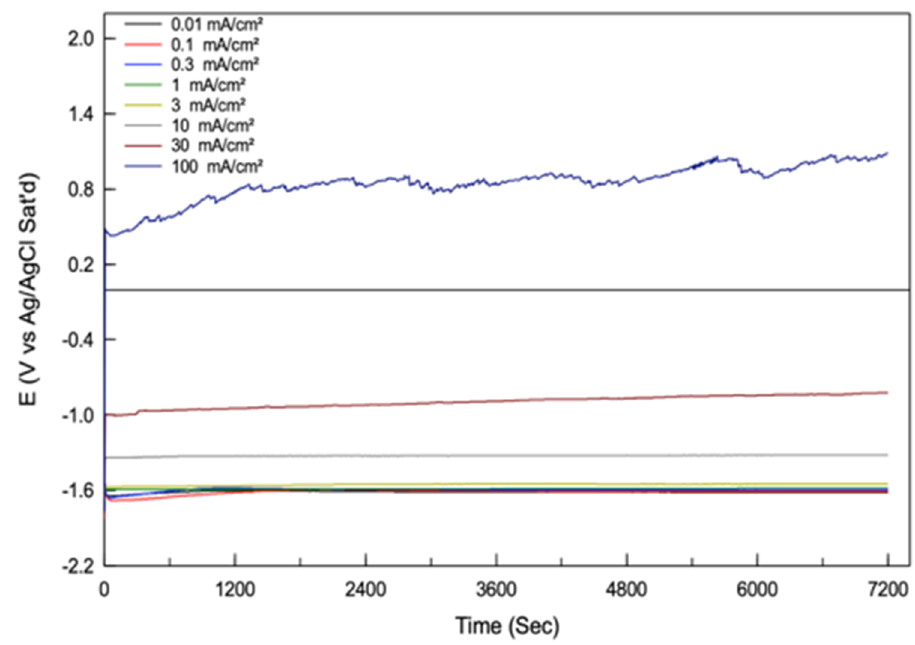
Figure 12. Typical measurements [92] of the potential of pure Mg and the Mg alloy WE43 during the anodic polarizations presented in Figure 11.